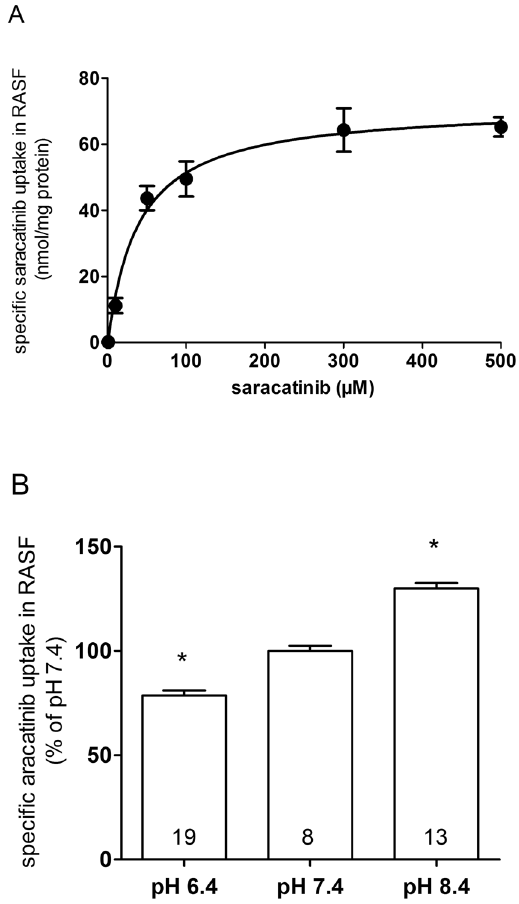
Figure 2. Characteristics of saracatinib uptake in hRASF. ( A ) Concentration-dependent uptake of saracatinib by RASF after 10 min incubation (n = 6–16) using the HPLC-UV method to quantify intracellular saracatinib levels. The kinetic parameters K m and V max values were estimated by least-square nonlinear regression analysis using GraphPadPrism 5 software. ( B ) Influence of altered extracellular pH on saracatinib accumulation into RASFs quantified by intracellular levels of saracatinib via the HPLC-UV method. Values are mean ± SEM expressed as percentage of saracatinib uptake at pH 7.4, which was set to 100%. Asterisks * indicate significant differences from saracatinib transport at pH 7.4 in RASFs, calculated by one-way ANOVA followed by Dunnett’s test ( P < 0.05). The numbers in the columns indicate the number of